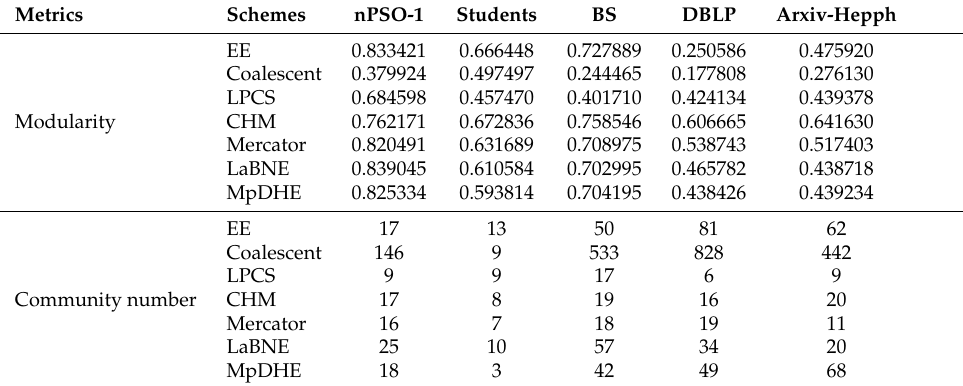
Table 6. Community discovery on dynamic networks.